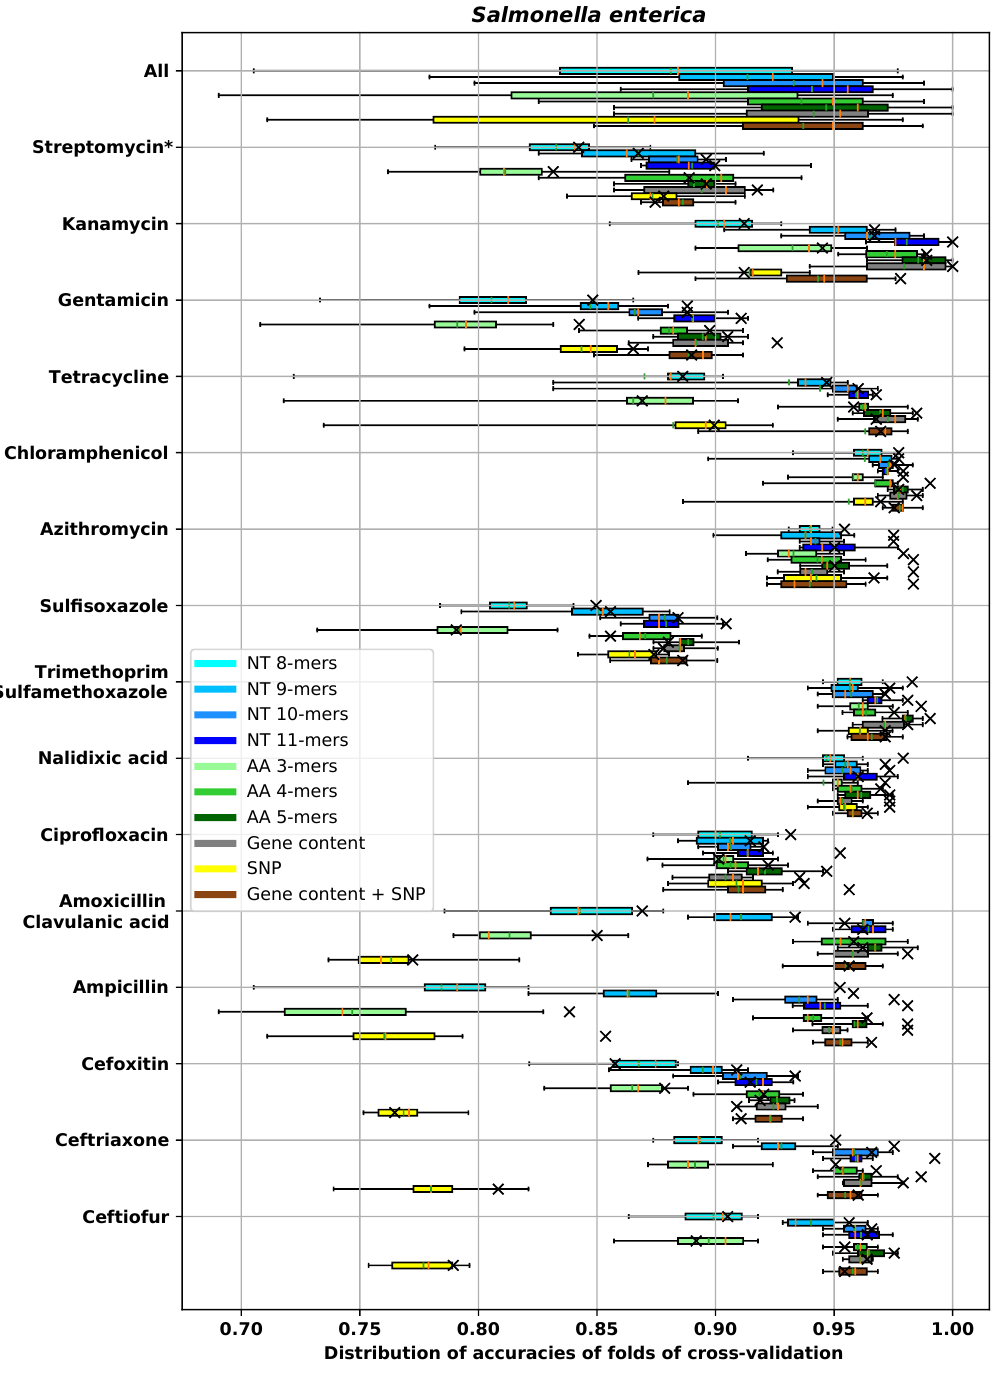
Figure 8. Distribution of ± 1 two-fold dilution accuracies in different methods for S. enterica . Plots are similar to Figure